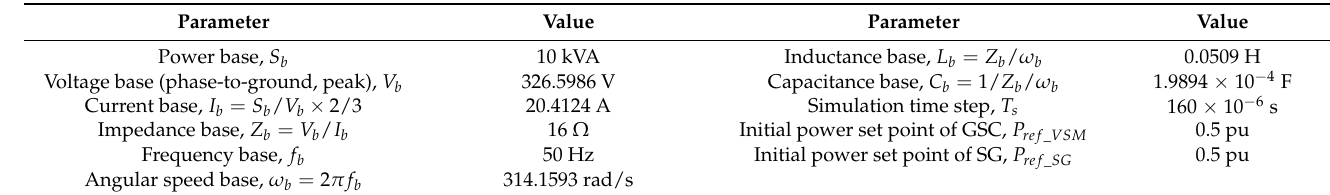
Table A1. Per unit representation and simulation settings.